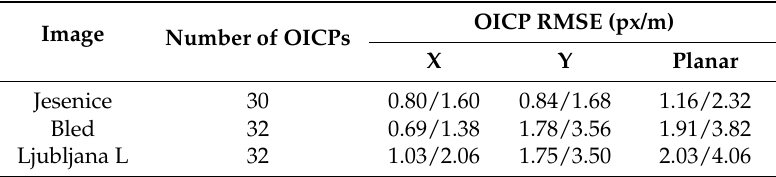
Table 6. Accuracy of the WorldView-2 orthoimages generated with the physical model compared to the reference aerial orthophoto.